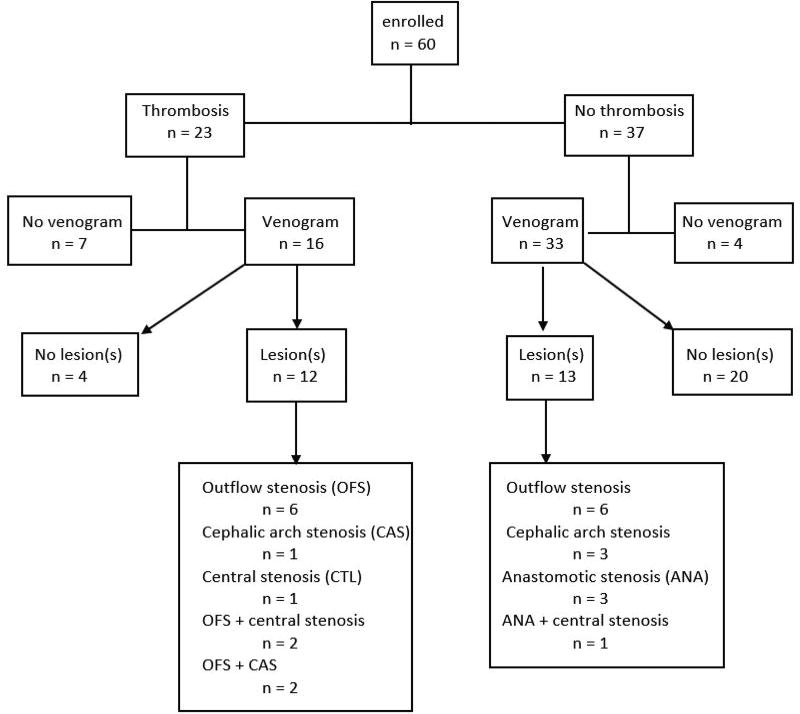
Flow diagram of CohortOFS: Outflow Stenosis; CAS: Cephalic Arch Stenosis; CTL: Central Stenosis; ANA = Anastomotic Stenosis.